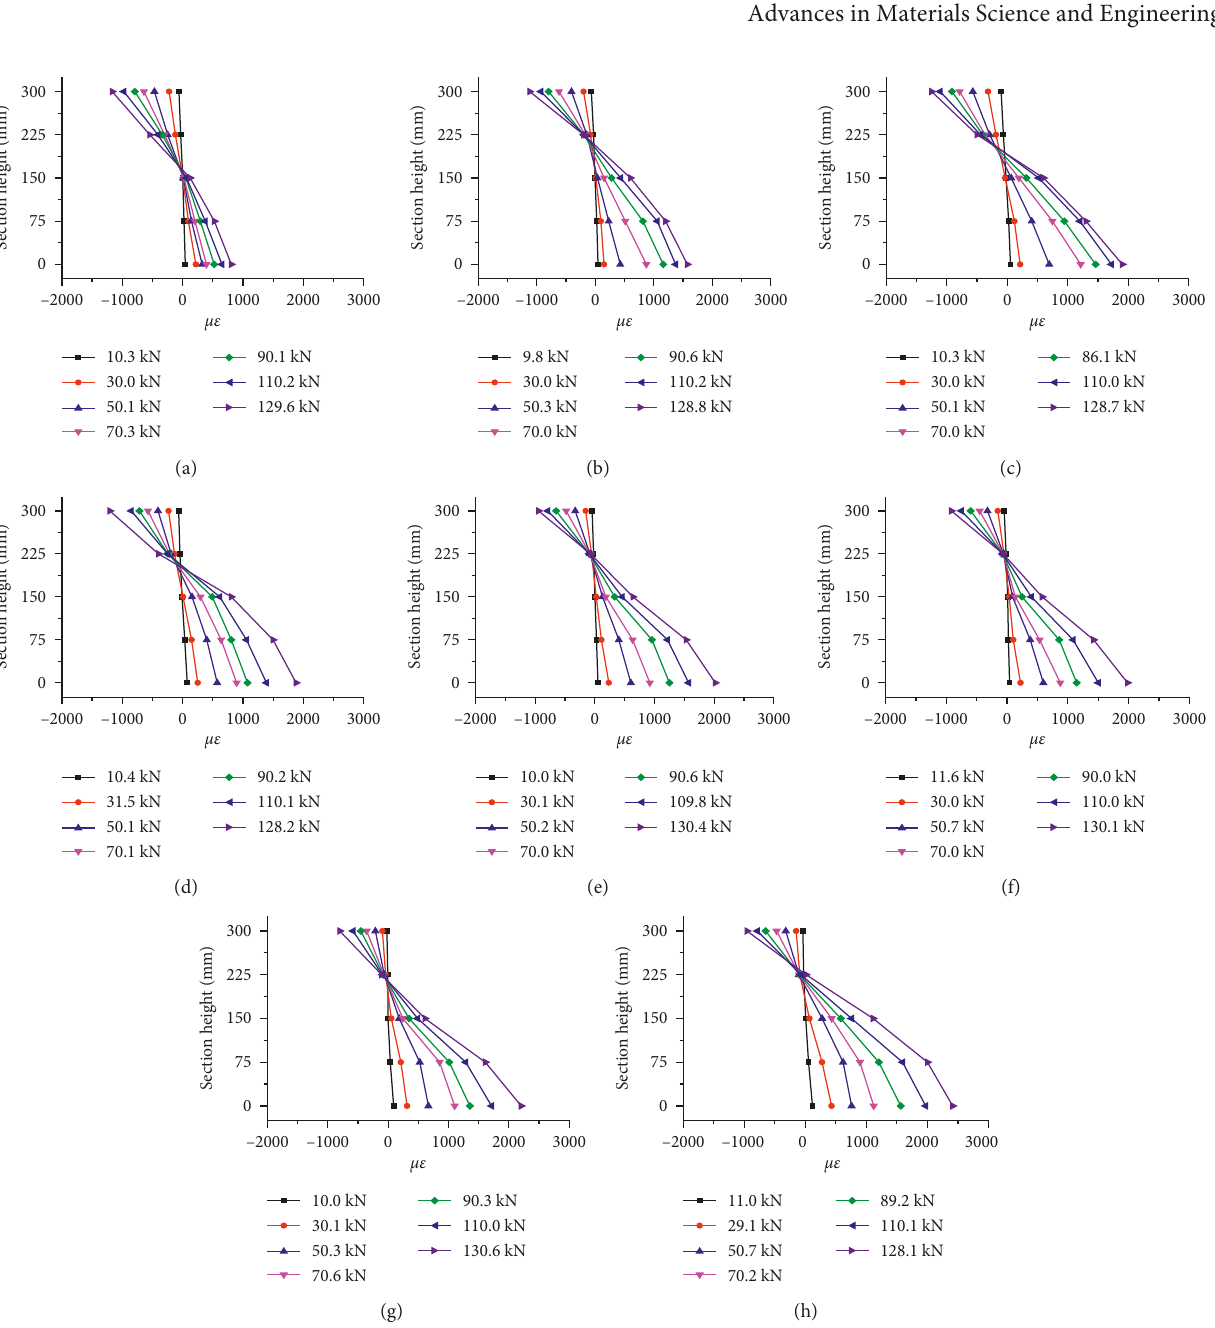
Figure 9: Concrete strain distribution of the eight specimens. (a) RCB-0, (b) RCB-33, (c) RCB-66, (d) RCB-100, (e) HRCB-0, (f) HRCB-33, (g) HRCB-66, and (h)